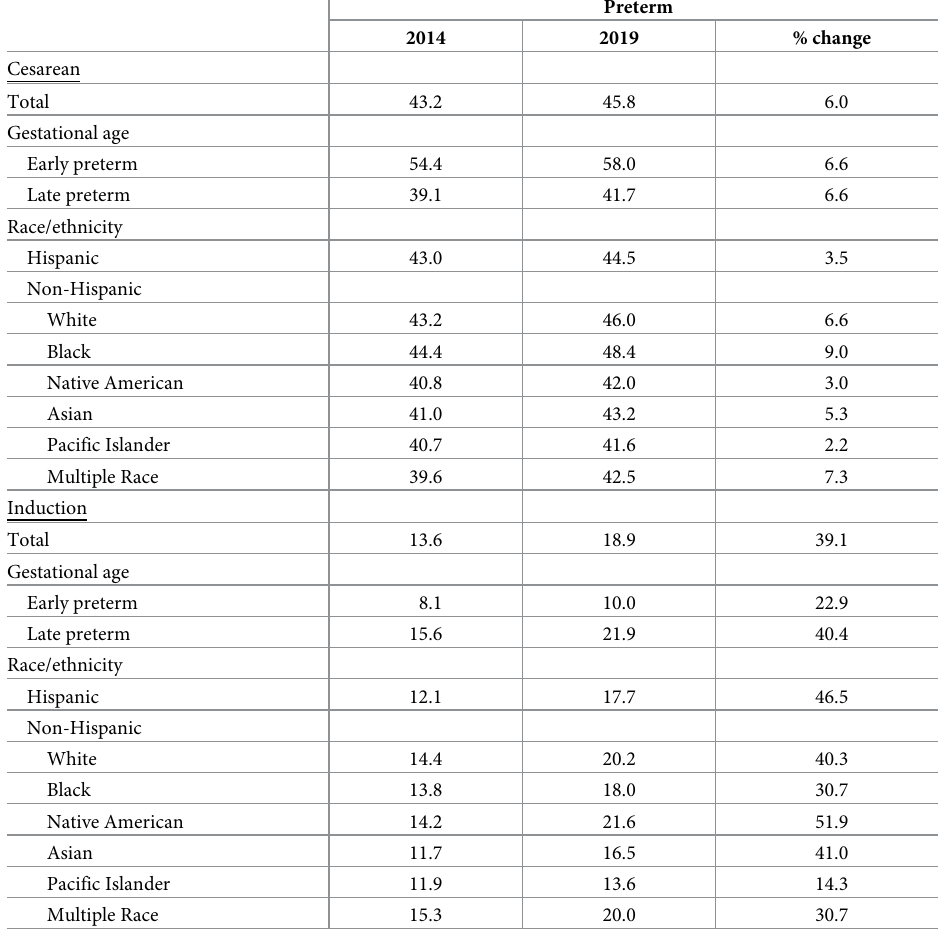
Table 2. Percentage of singleton preterm births with cesarean or induction of labor by gestational age and mater- nal race/ethnicity, United States, 2014–2019.